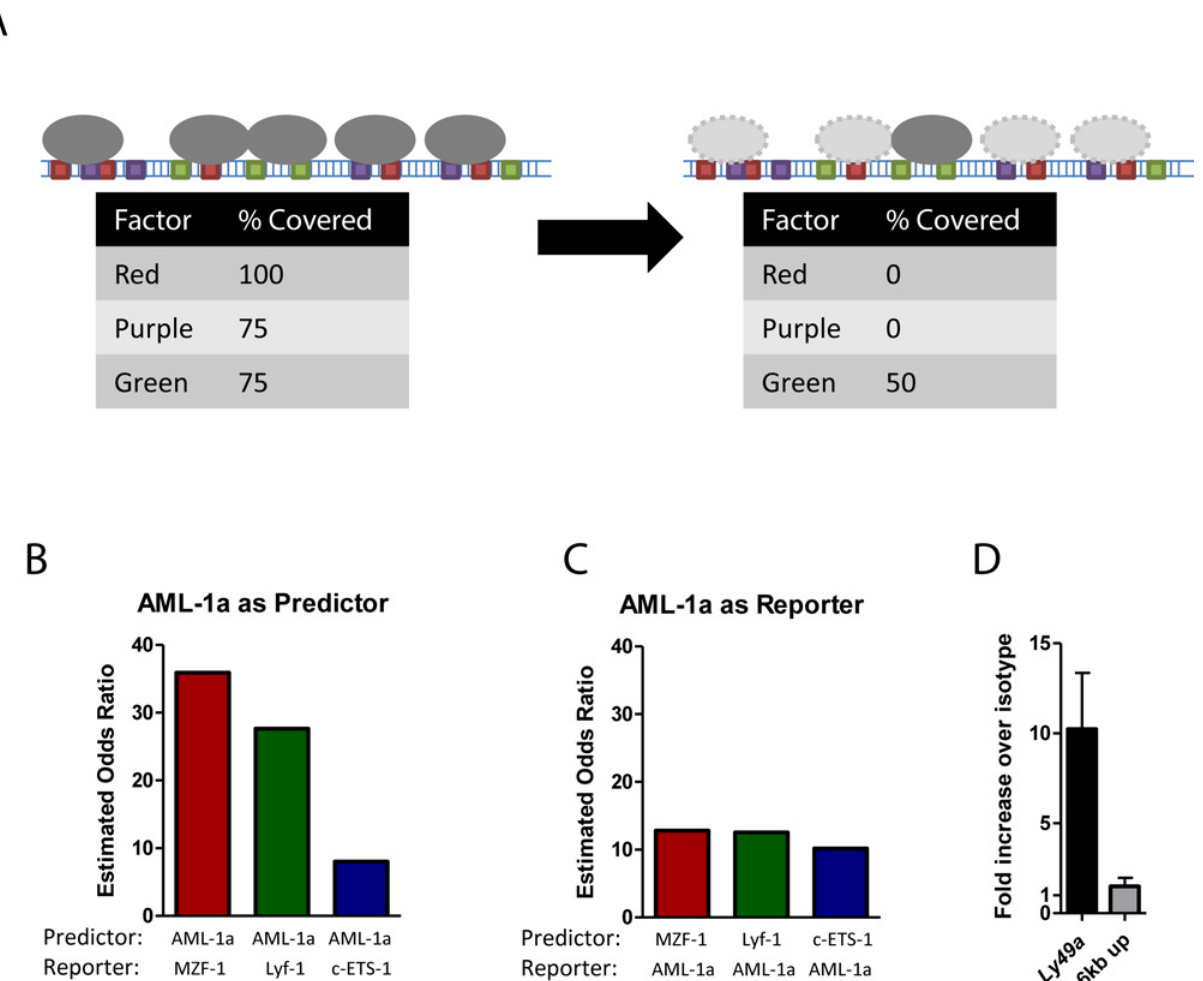
Fig 5. Confounding variables unlikely to account for AML-1a-specific nucleosome depletion in Ly49A. (A) Schematic highlighting the possibility of confounding variables impacting transcription factor/nucleosome relationship studies. If an event occurs to deplete all nucleosomes covering a red factor, the coverage of the red factor drops from 100% to 0%. However, the coverage of all purple factors drops from 75% to 0%, and green from 75% to 50%. Taking nucleosome coverage as the readout, it is impossible to determine whether the red, purple, or green factors ‘ caused ’ the nucleosome depletion. However, if red depletions are always correlated with purple depletions, while purple depletions only occasionally predict red depletions, it is likely that red is causing the nucleosome remodeling. (B-C) Logistic regression analysis was performed for each of the four most depleted transcription factors from 4C (AML-1a, c-ETS- 1, Lyf-1, and MZF-1), using (B) AML-1a as the predictor, or (C) AML-1a as the reporter. In each case, AML-1a was a better predictor of the other two nucleosome-preferring factors, Lyf-1 and MZF-1, than either were of AML-1a. AML-1a performed equally well as predictor or reporter against c-ETS-1, a factor that had no preference for nucleosome coverage, and so was unlikely to be involved as a confounding variable. (D) Chromatin immunoprecipitation (ChIP) using anti-AML-1 or an irrelevant isotype control was performed on RMA chromatin extract. ChIP using the anti-AML-1 antibody resulted in about a 10-fold enrichment of the Ly49A promoter region when compared to ChIP using the isotype control, indicating that AML-1 is likely bound to the promoter. As a control, a region of DNA approximately 6 kbp upstream of the Ly49A promoter displayed no such